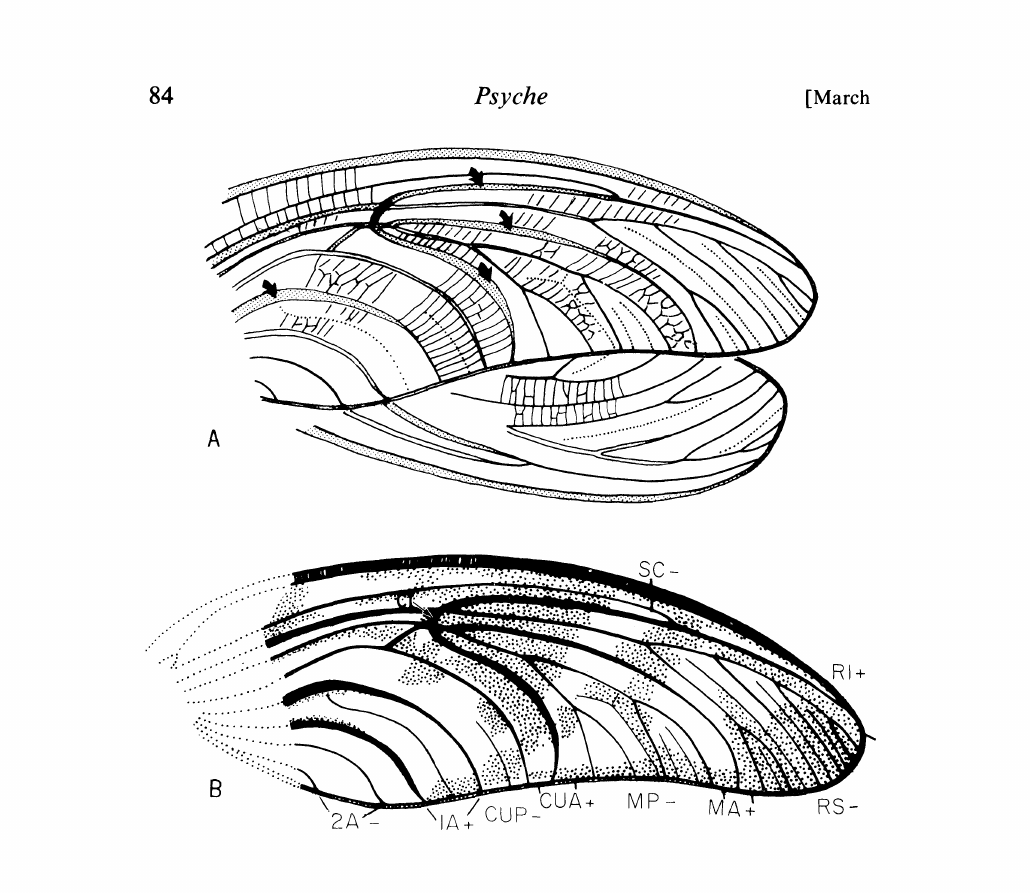
Fig. 3. Moravia convergens, young nymphal fore wings, with distal half curved posteriorly. A. Actual specimen, arrows pointing to broad veinal blood sinuses. B. Reconstructed wing pad with color pattern. Lower Permian of Czechoslovakia.